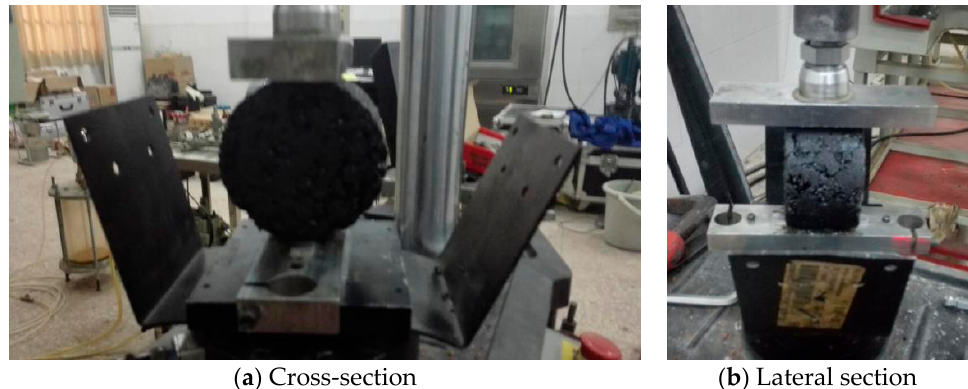
Figure 6. Indirect tensile fatigue test in the laboratory.